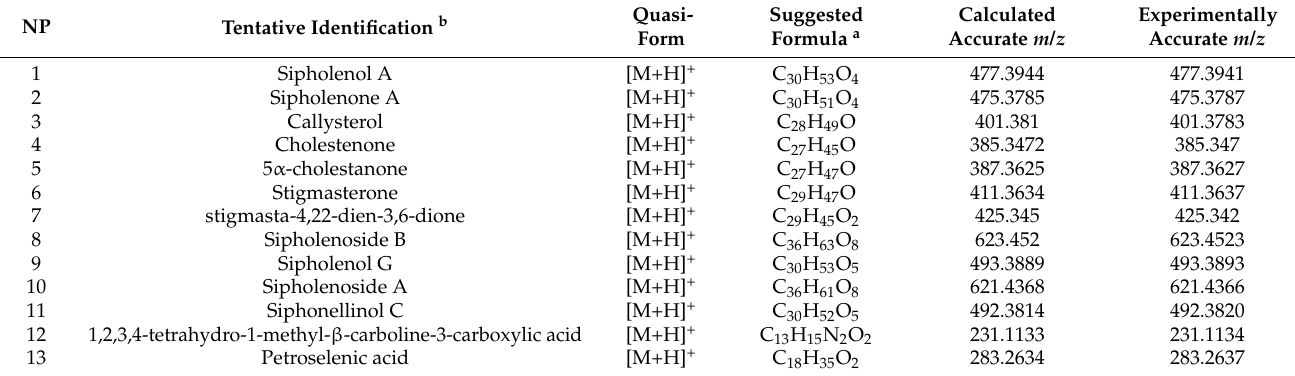
Table 1. Dereplication of the metabolites identified from C. siphonella DCM fraction.